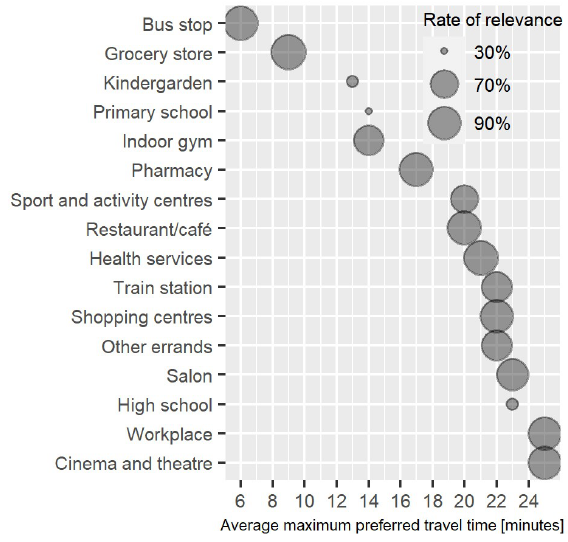
Figure 3. The average maximum preferred travel time by the various trip purposes. The dots’ sizes rep- resent the share of applicability for the respondents.